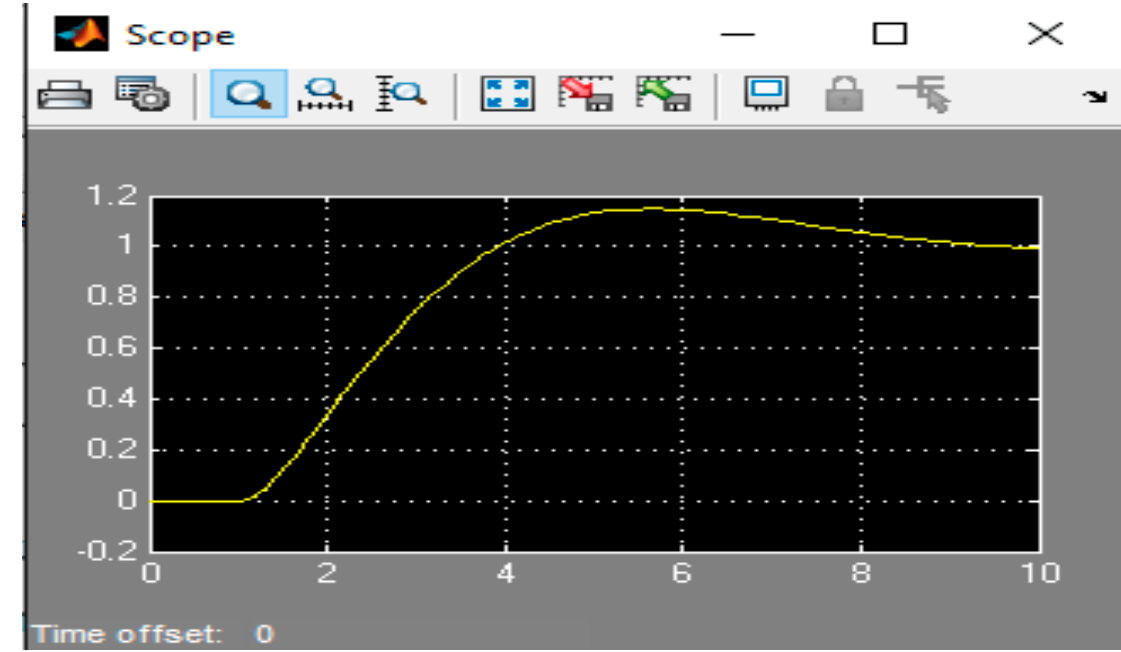
Figure 16. Simulation of diesel engine speed control process.